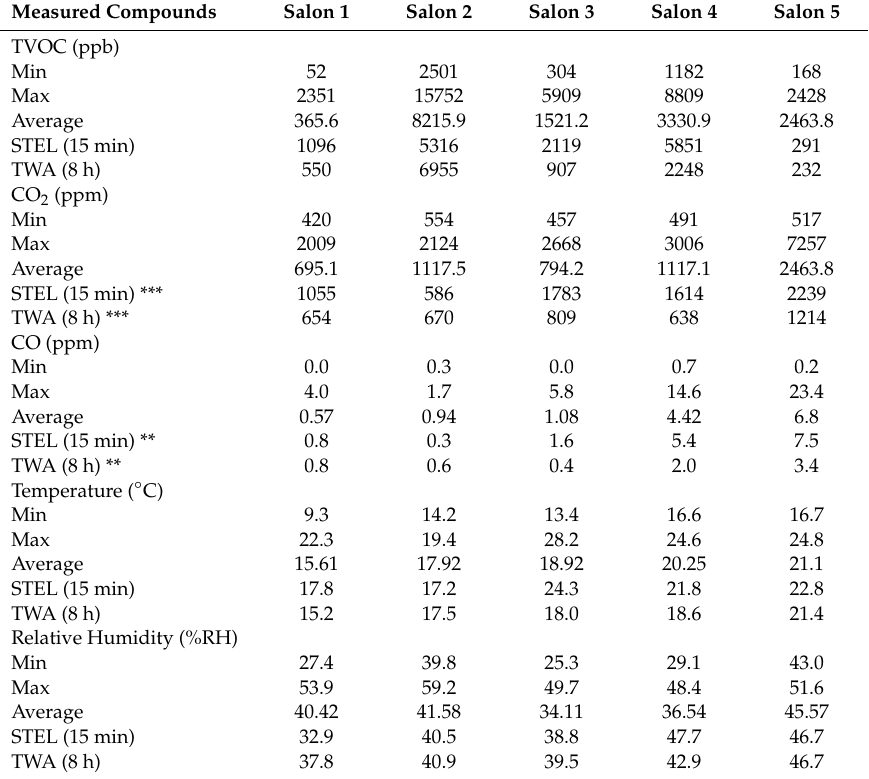
Table 4. Indoor environmental